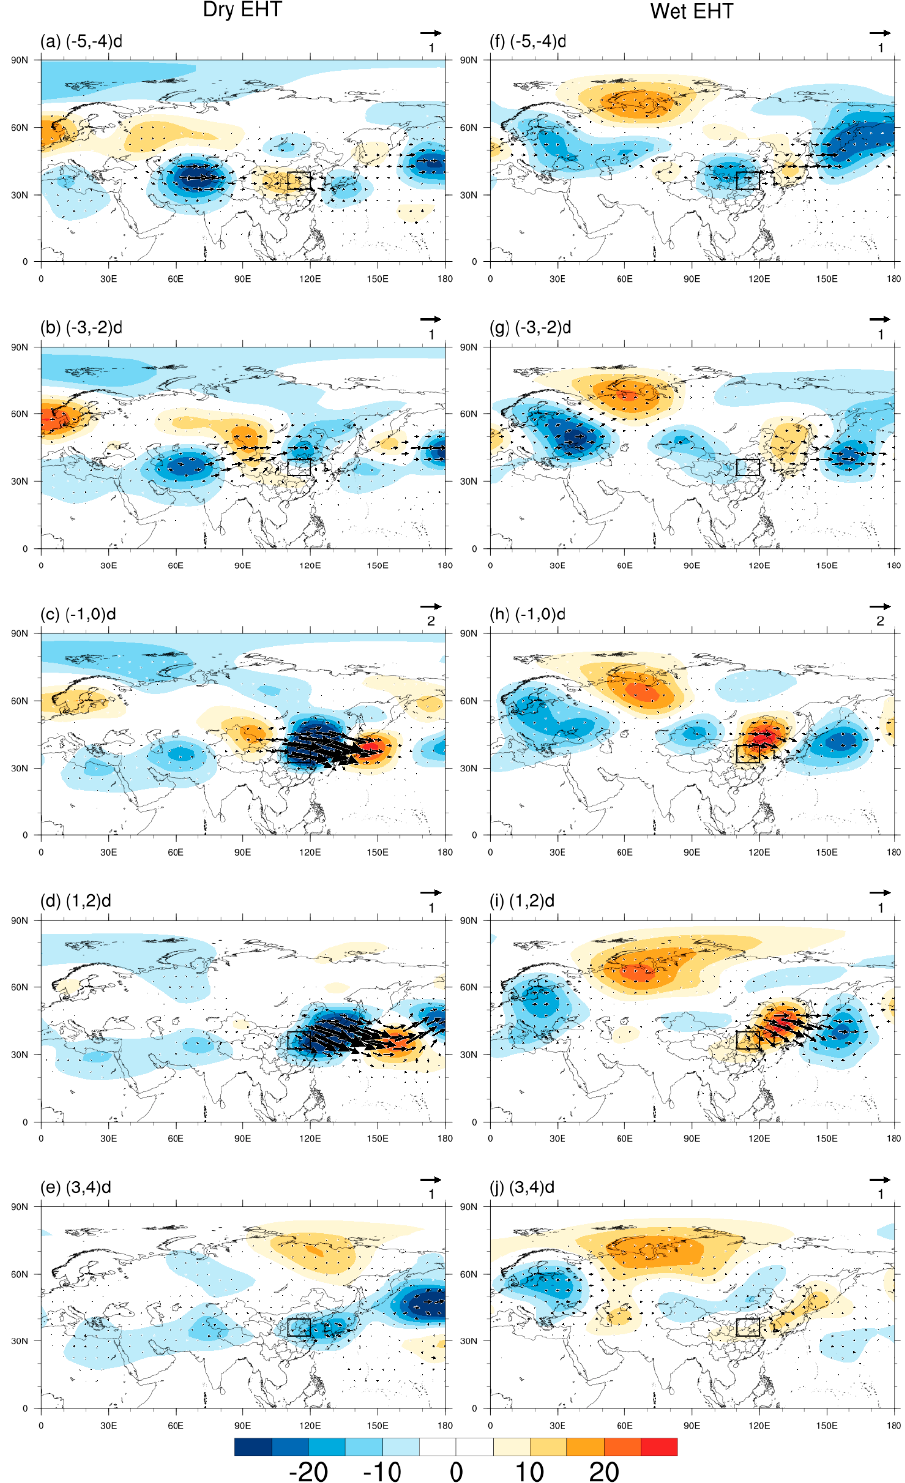
Figure 7. Composite evolution of 200 hPa Plumb wave activity flux (vectors; unit: m 2 /s 2 ) and geopotential height anomalies (colors; unit: gpm) (from day − 5 to day − 4 for ( a – e ): dry EHT onset days, ( f – j ): wet EHT onset days).